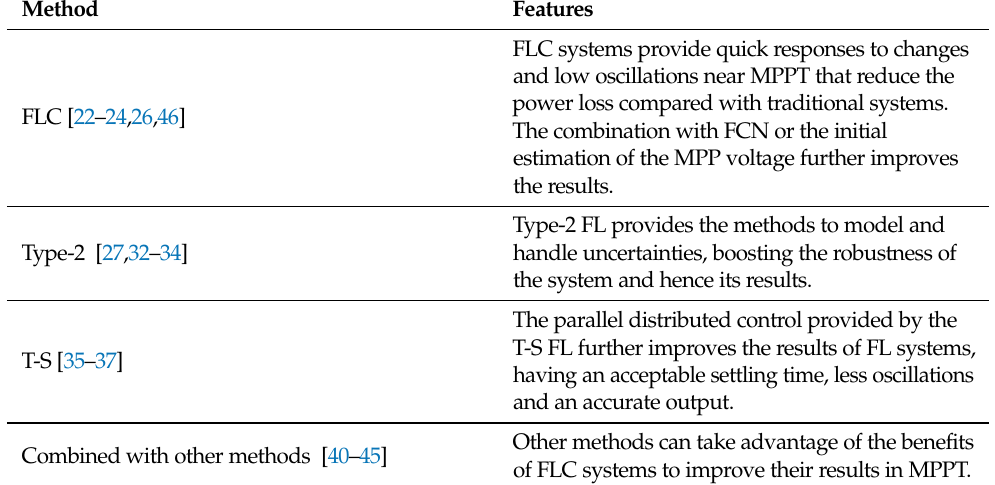
Table 2. Fuzzy Methods for